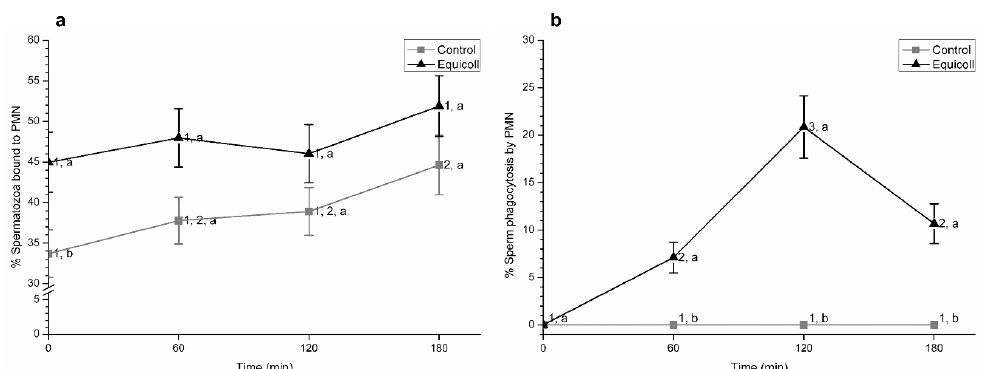
Figure 7. Percentages of ( a ) spermatozoa bound to PMN and ( b ) sperm phagocytosed by PMN in control (non-selected samples) and SLC-selected samples (Equicoll). Different superscript letters (a, b) indicate significant differences ( p ≤ 0.05) between treatments within a given time point, and different superscript numbers (1, 2) mean significant differences between time points within the control or samples selected with Equicoll. Data are shown as mean ± SEM for 7 separate experiments. SLC: single layer centrifugation. PMN: Polymorphonuclear neutrophils.